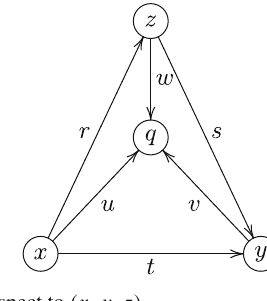
Fig. 2 The relations r and s are linked with respect to ( x , y , z